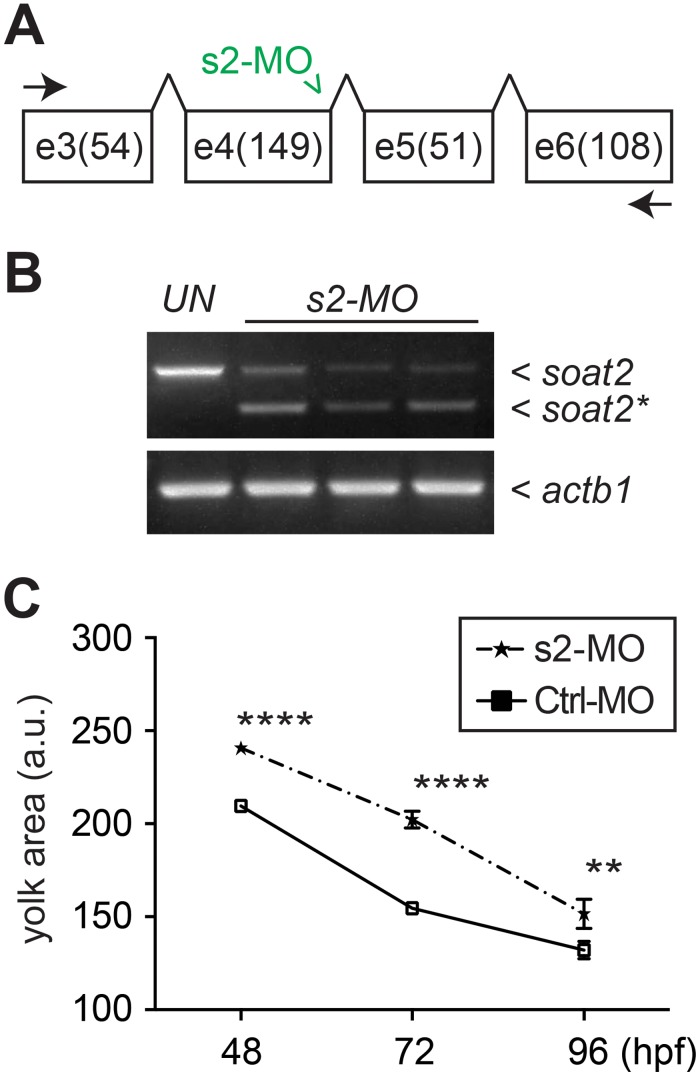
The yolk size phenotype in yolk-soat2 knockdown zebrafish embryos.(A) The soat2 specific morpholino (s2-MO) was designed to target on the boundary of exon 4 and intron 4 (green concaved arrowhead). Specific primers for amplifying targeted sequence flank exon 3 through exon 6 (concaved arrows). (B) The effect of s2-MO was confirmed by reverse-transcription polymerase chain reaction (RT-PCR) and a shorter product (soat2*) was observed with the expected normal product (soat2) when s2-MO was injected to the embryos. The sequence of soat2* was confirmed to lack of the entire exon 4 and predictively to give rise to a truncated protein with only 99 amino acids. (C) The embryos with yolk injection of s2-MO at 3 hpf showed significantly larger yolk size when compared to the embryos received control morpholino (Ctrl-MO).